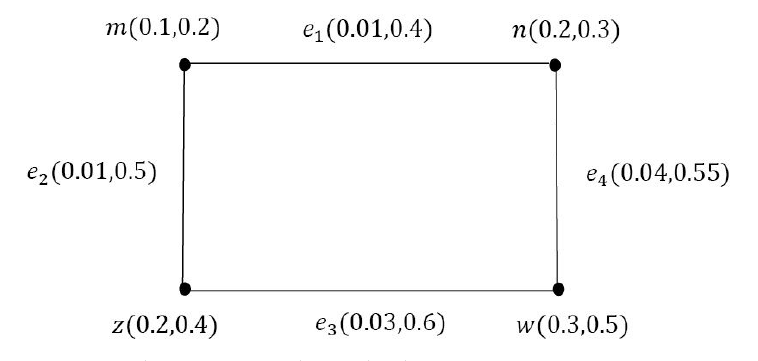
Figure 7. Product vague graph ζ with edge covering